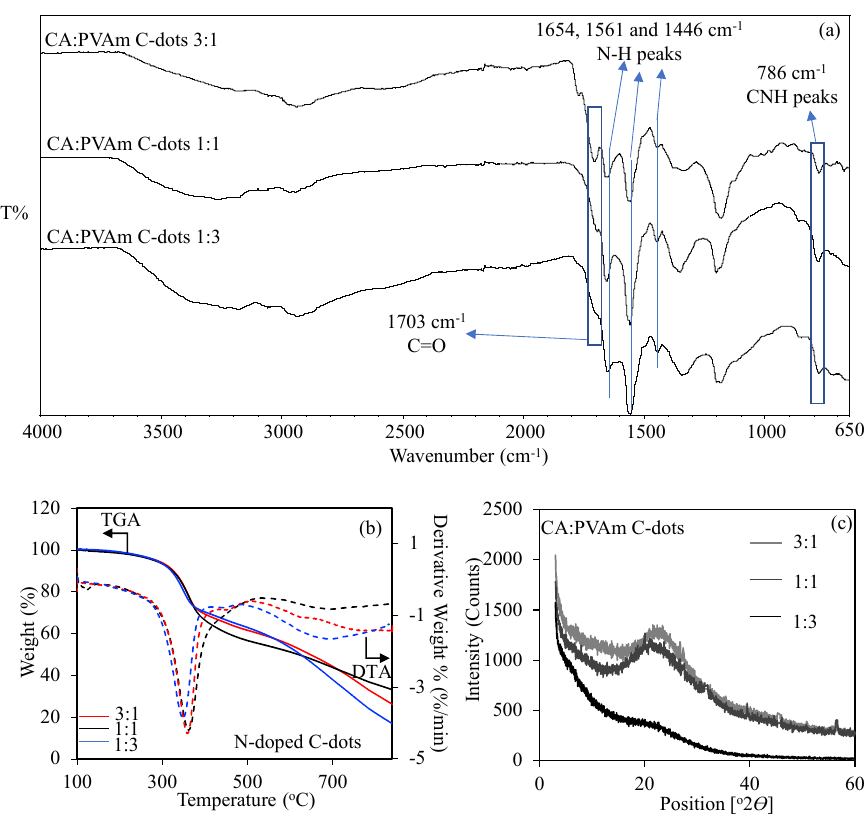
Figure 3. The ( a ) FT-IR spectra, ( b ) TGA thermograms, and ( c ) XRD patterns of N-doped C-dots at different ratios of CA:PVAm precursors.